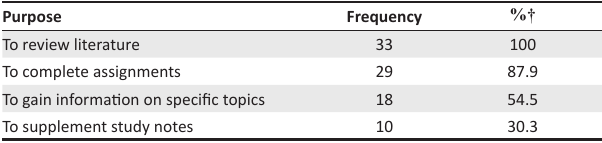
TABLE 1: Purposes of using e-resources by postgraduate